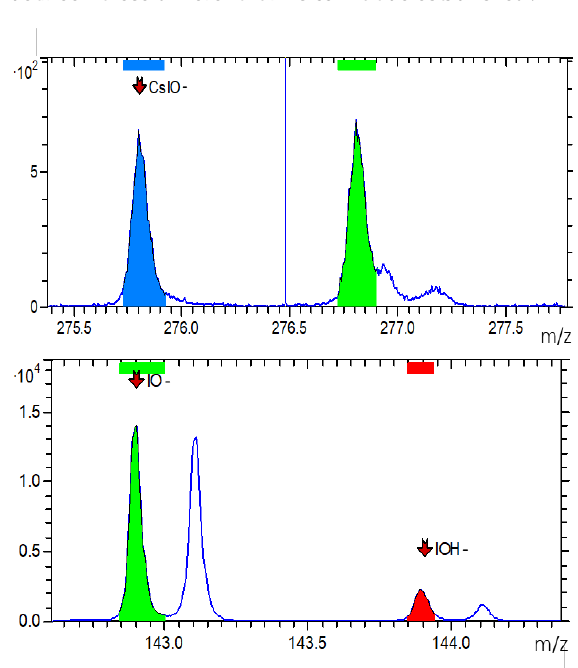
Figure 3: ToF SIMS spectrum of CsI deposit on SS coupon after revaporization at 410°C (with a Bi + ion beam and a negative